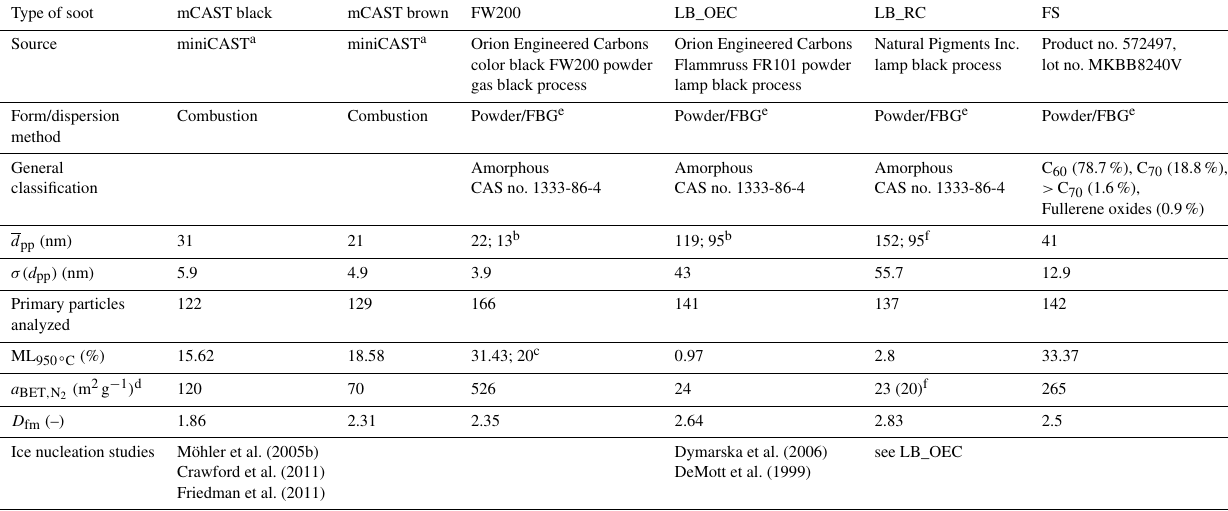
Table 1. Particle characteristics of soot types investigated in this study, where d pp denotes the mean physical diameter of primary particles, as obtained from TEM evaluation of the number of primary particles indicated, and σ(d pp ) the corresponding standard deviation; a BET , N denotes the BET specific surface area using N 2 adsorption at 77K and ML 950 ◦ C the mass loss at 950 ◦ C measured by thermogravimetric analysis, as an upper limit of heat-sensitive material associated with the soot. D fm denotes the fractal dimension derived from power–law fits of the form of Eq. (A4) to mass–mobility data.